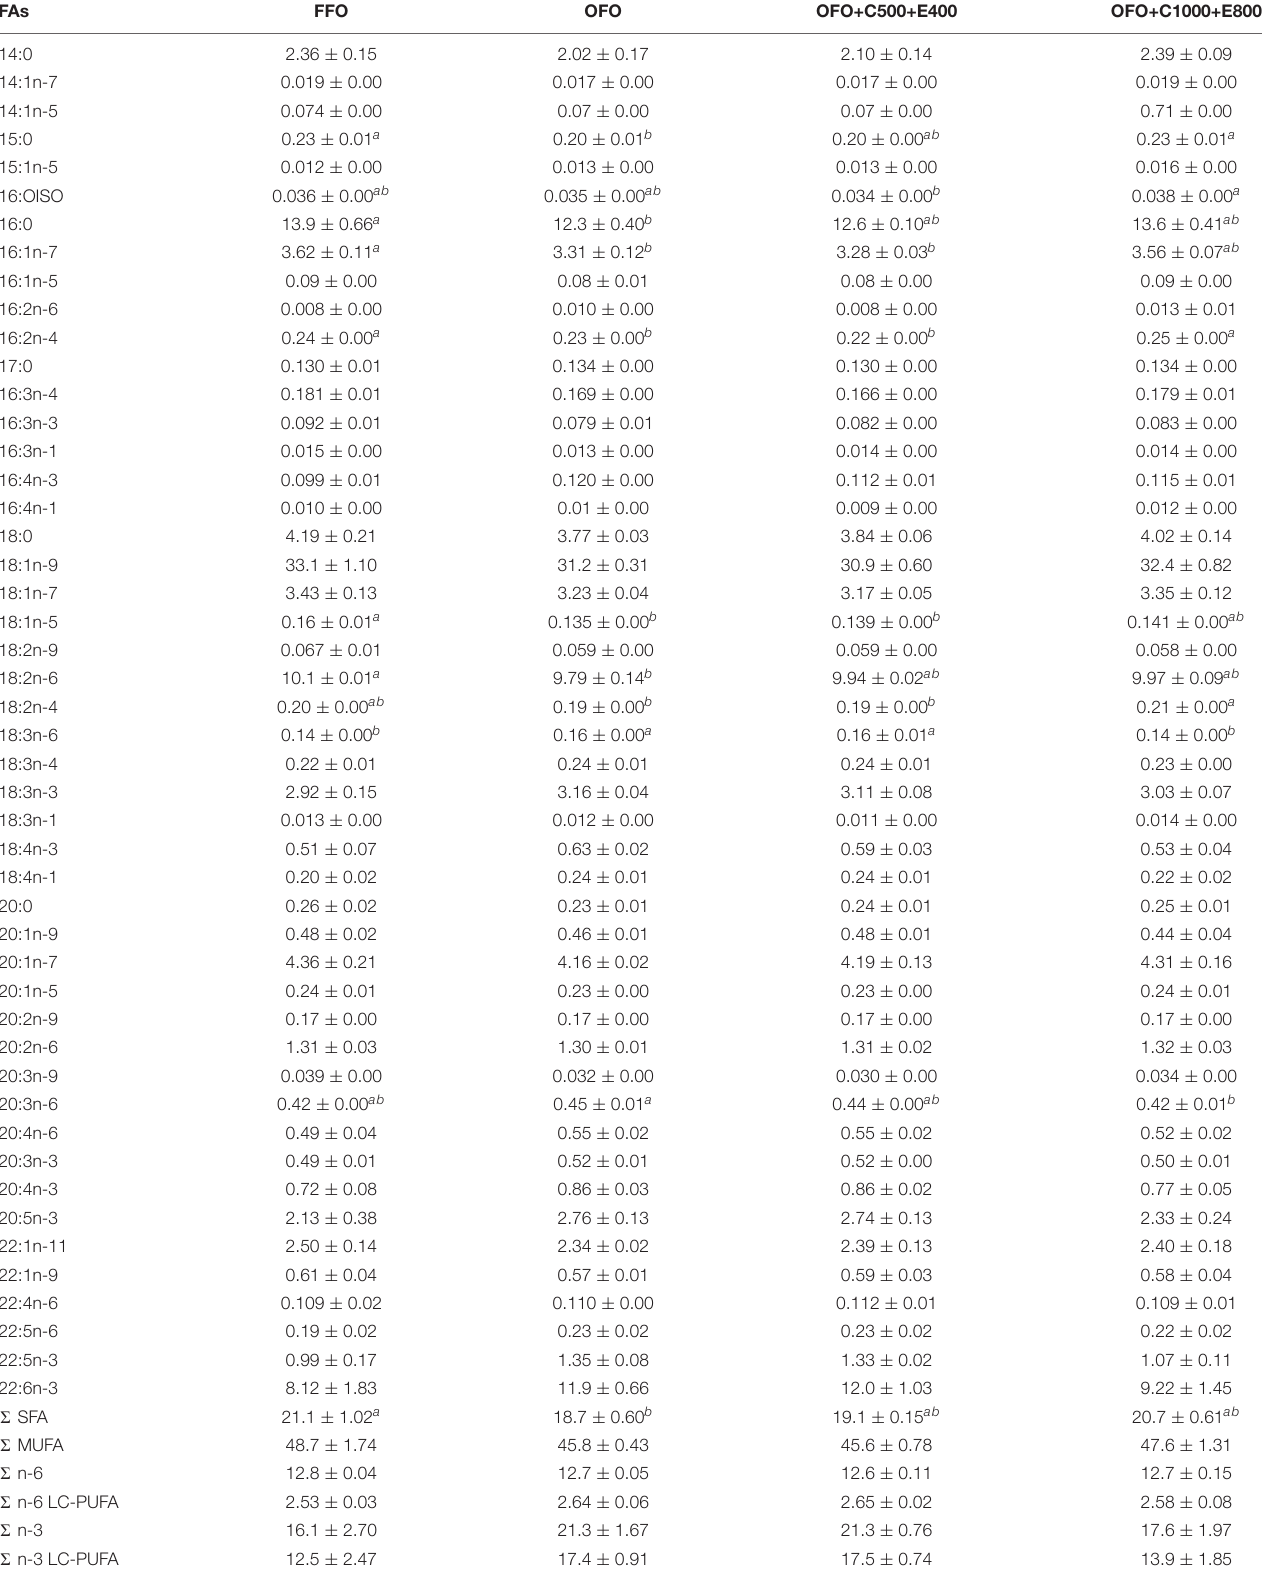
TABLE 4 | Muscle fatty acid (FA) composition of rainbow trout fed the experimental diets for 10 weeks (% total identified FA). FAs FFO OFO OFO+C500+E400